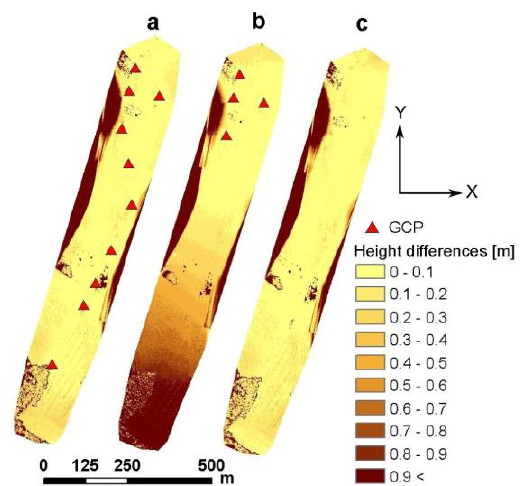
Figure 9. DSM differences with respect to the reference